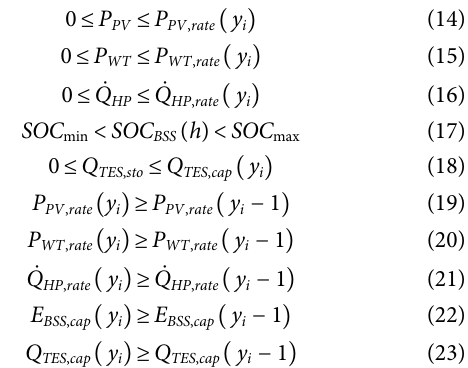
Figure 2 . The prediction shows that the unit prices of PV, WT,